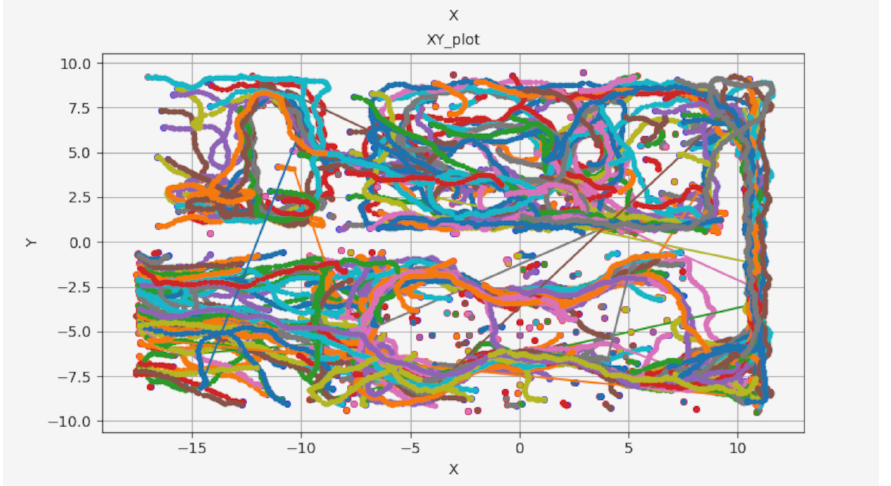
Figure 12. This diagram illustrates the navigation of UAV using untrained SCAN in the challenging environment (XY plane).